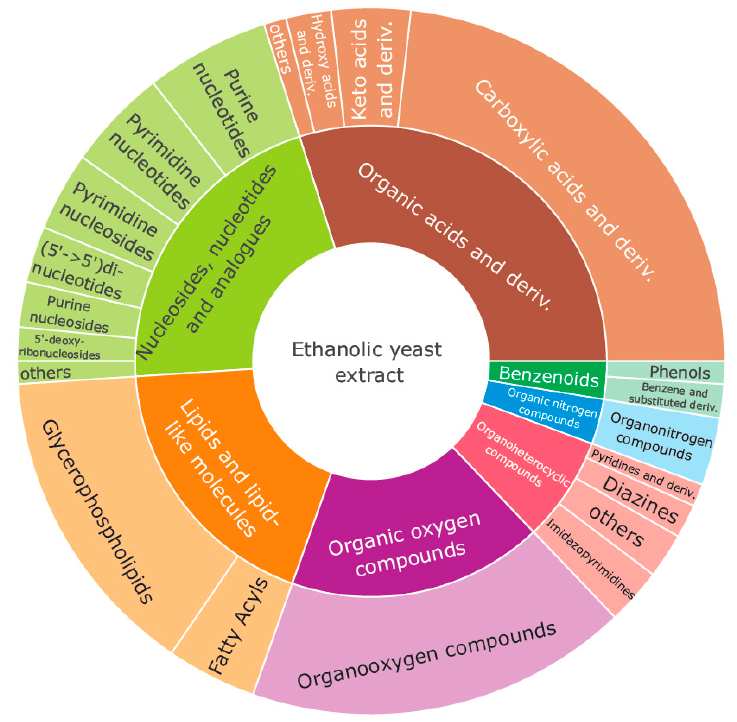
Figure 1. Annotated metabolite classes in ethanolic yeast extract using the classyFire [40] annota- tion system.